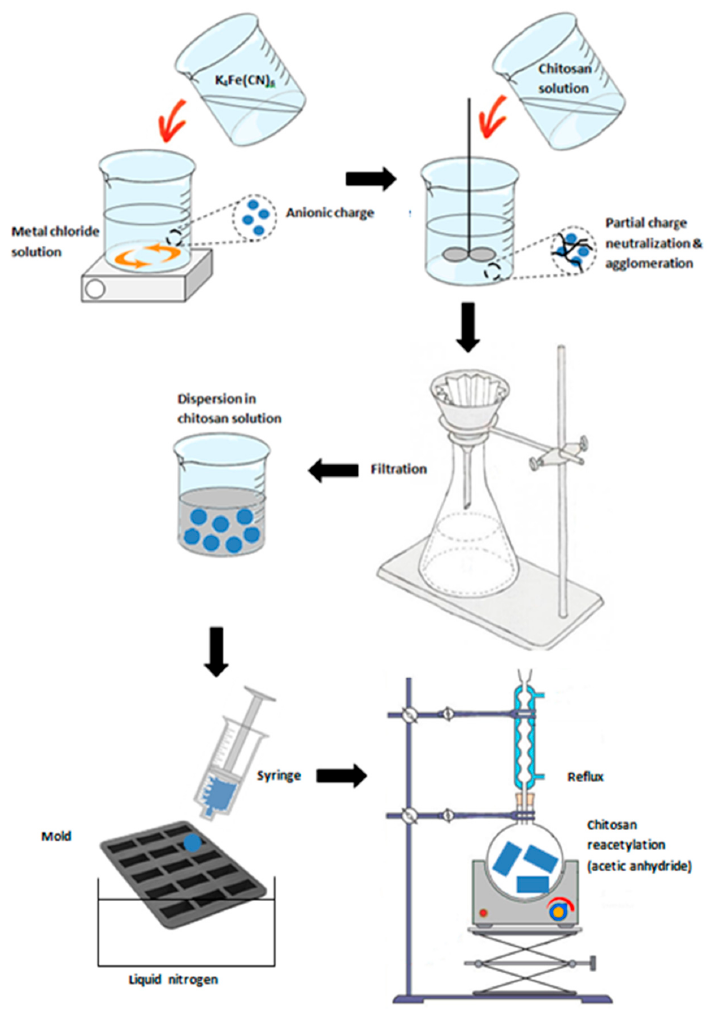
Figure 5. Schematic route for the synthesis of chitin sponge composites.